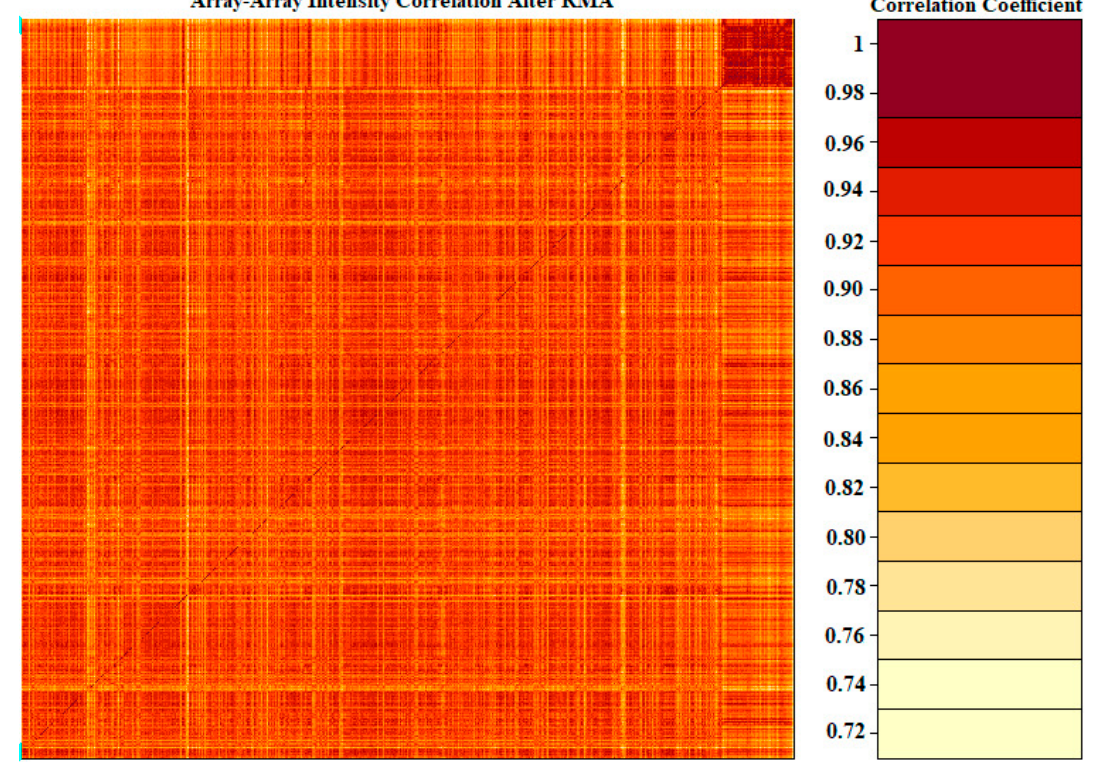
Figure 2. Array-Array Intensity Correlation (AAIC).